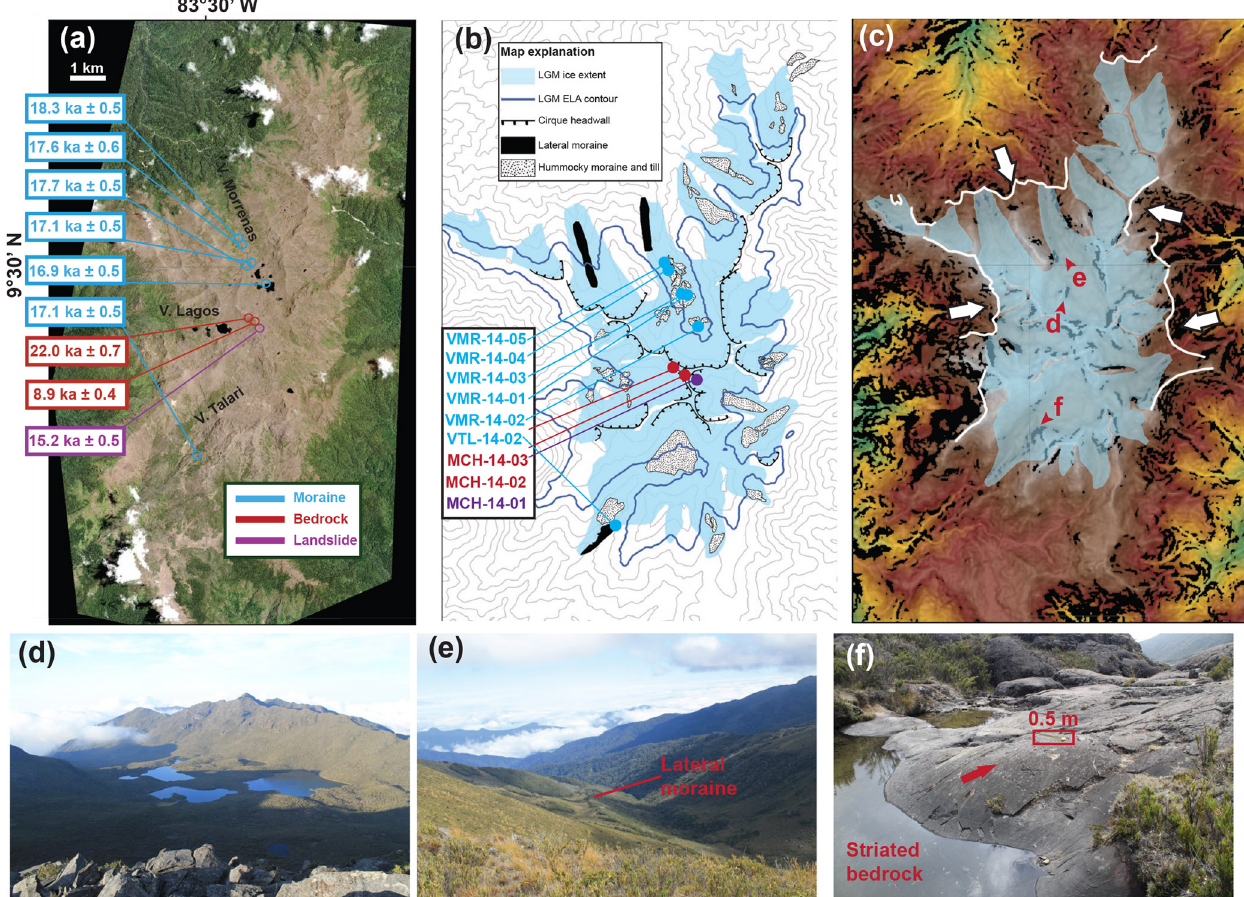
Figure 9. Cerro Chirripó glacial geomorphology. (a) Worldview-2 image with 10 Be exposure age dates. (b) Simplified glacial geomorphic map of Chirripó. Heavy blue line is contour of estimated LGM ELA (3500m). Sample locations are the same as in panel (a) . Contour interval is 100m. Sample names correspond to field photos in Fig. 7. (c) SRTM DEM (green through red). Steep slopes ( > 30 ◦ ) in black. Mapped ice extent is light blue. White lines are escarpments, and white arrows indicate direction of scarp encroachment. Red letters and arrows indicate vantage orientation of field photos (d) – (f) . (d) View of cirque floor in Valle de las Morrenas. Lakes are dammed by recessional moraines. (e) Two-kilometer long lateral moraine at the base of Valle de las Morrenas. (f) Striated bedrock in Valle Talari. Red arrow indicates direction of ice